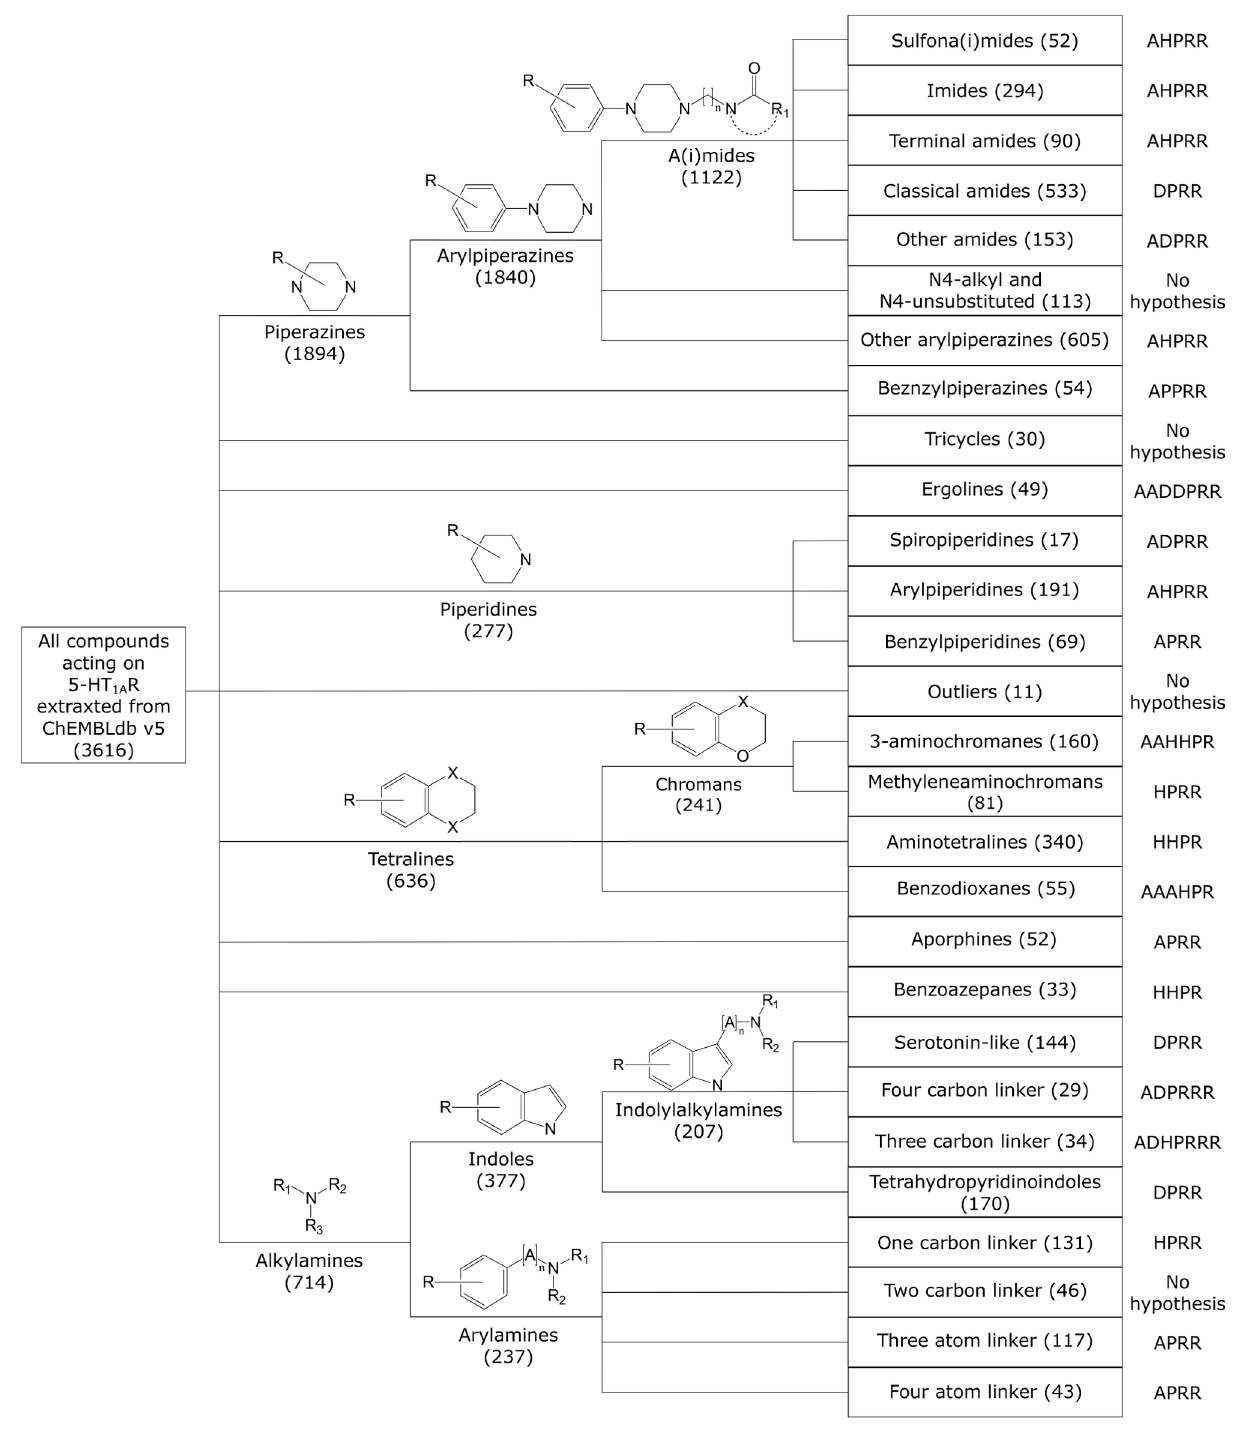
Figure 3. A dendrogram obtained using the manual clustering procedure. A dendrogram obtained using the manual clustering procedure. The number of compounds comprising each cluster is given in brackets. The last column presents a feature composition of the pharmacophore model created for a given cluster. The feature abbreviations used are: hydrogen bond acceptor – A , hydrogen bond donor – D , hydrophobic group – H , positively charged group – P , aromatic ring – R .